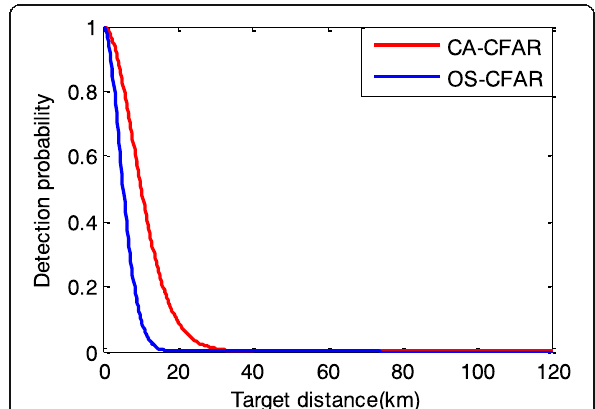
Fig. 11 Effect of two jammers on the detector ’ s performance with position error